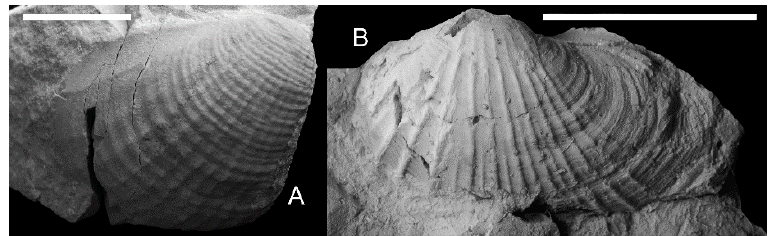
Figure 15. Appearances of ribs. ( A ), All ribs almost simultaneously; Ph. cf. acuminata (Oxfordian, Rz ę dkowice, Polish Jura, MGUS.Sz.3607)—but compare with Figure 12E. ( B ), Gradually, by intercalations; Ph. fidicula (Upper Bajocian, Cz ę stochowa, Polish Jura, MGUS.Sz.3880).